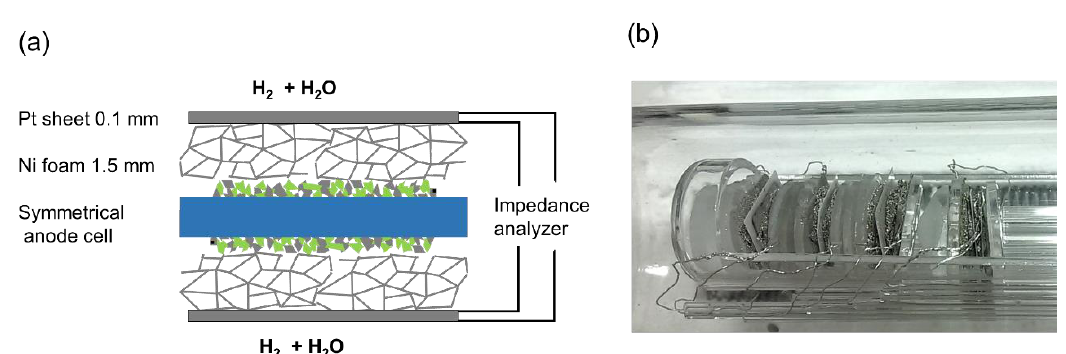
Figure 7. ( a ) Sketch of mounting and contacting of a symmetrical Ni/GDC anode cell. ( b ) Photograph of the cell measurement assembly. Four symmetrical cells are mounted in the single-chamber impedance test rig and measured in one run by a multiplexed